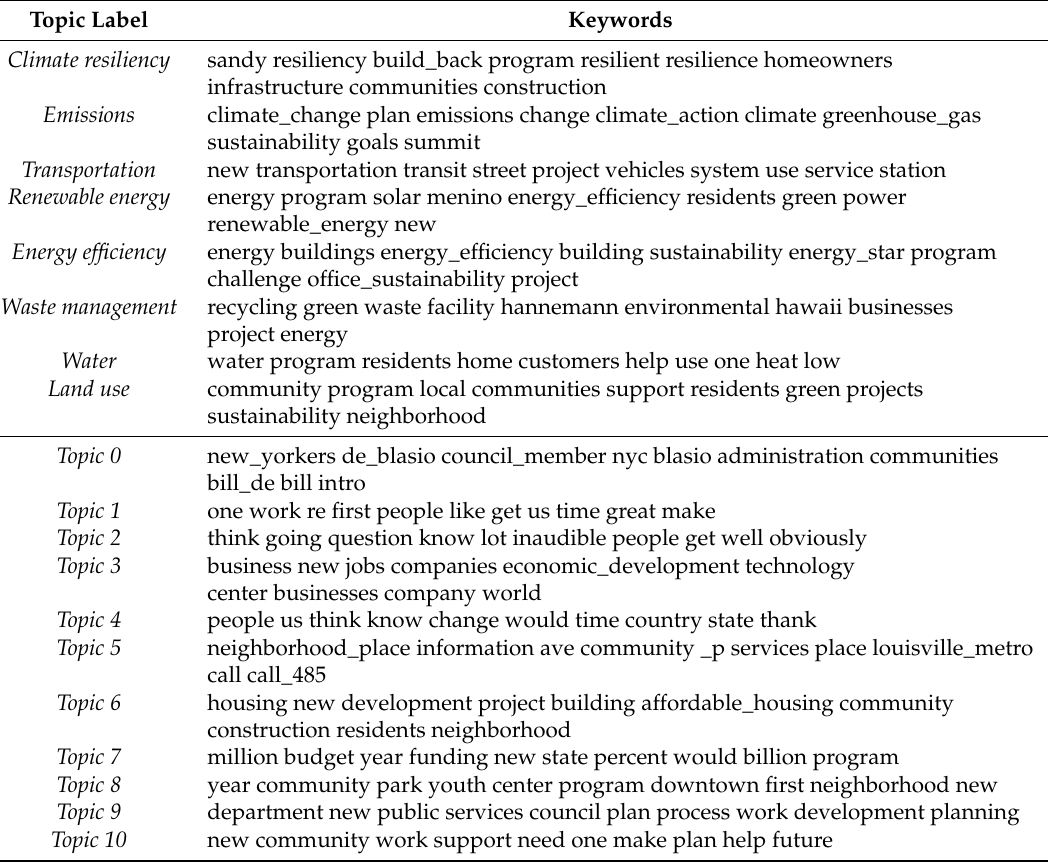
Table 1. Topic labels and top 10 most probable keywords of each